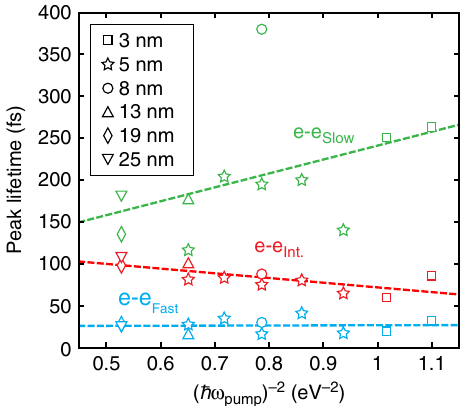
Fig. 9 Spacer and pump energy dependence of nonthermal response at the gap mode. Shift in the lifetime distribution peaks corresponding to nonthermal e – e scattering as pump energy ( ħ ω pump ) and Al 2 O 3 spacer thickness are varied. An opposite trend is observed for the intermediate carriers. The different dependence of peak lifetime vs. pump energy of the three e-e components supports their assignment to distinct nonthermal electron populations whose decay is not isotropic. The dashed lines are guides to the